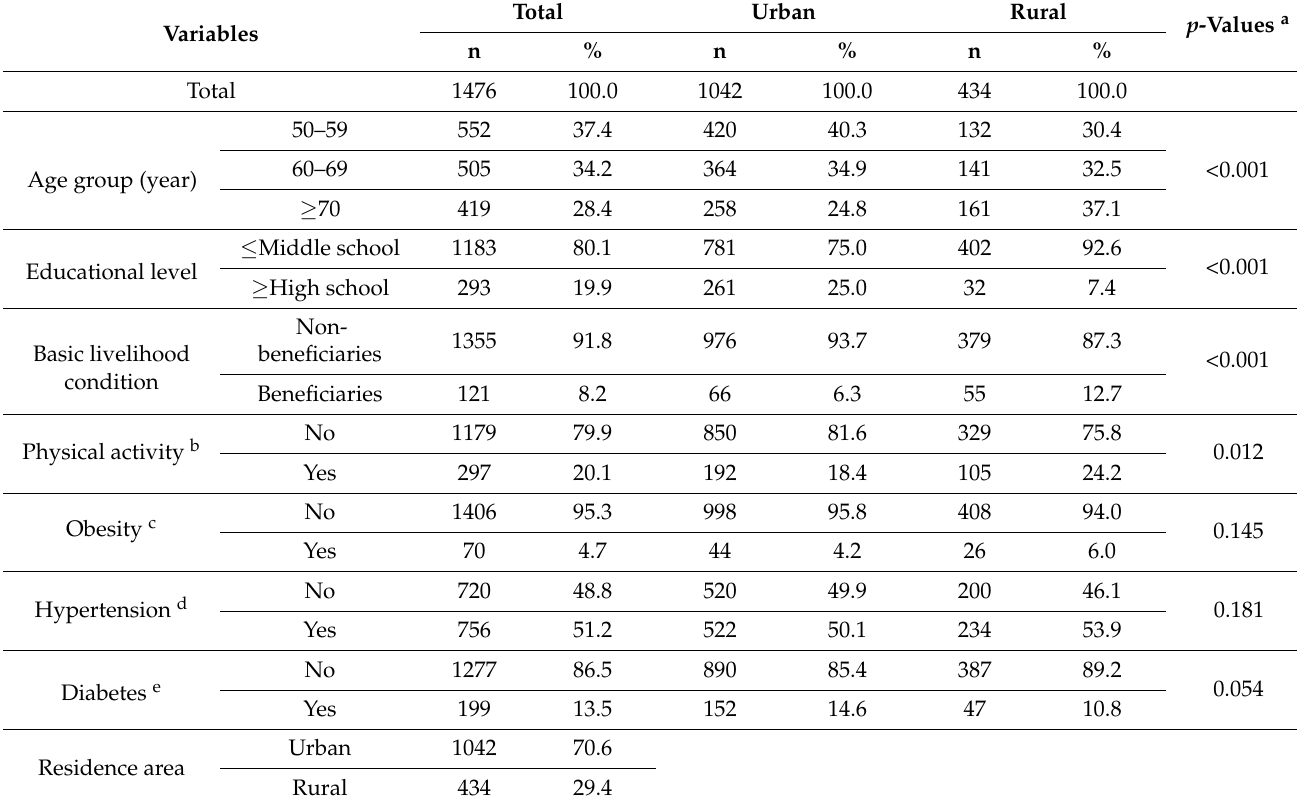
Table 1. General characteristics of the study